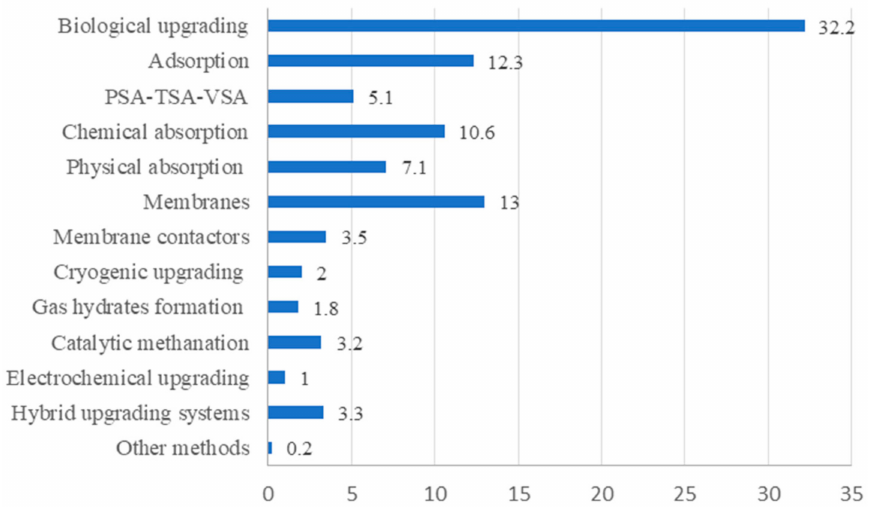
Figure 3. Distribution of publications by technology (number of articles, %).